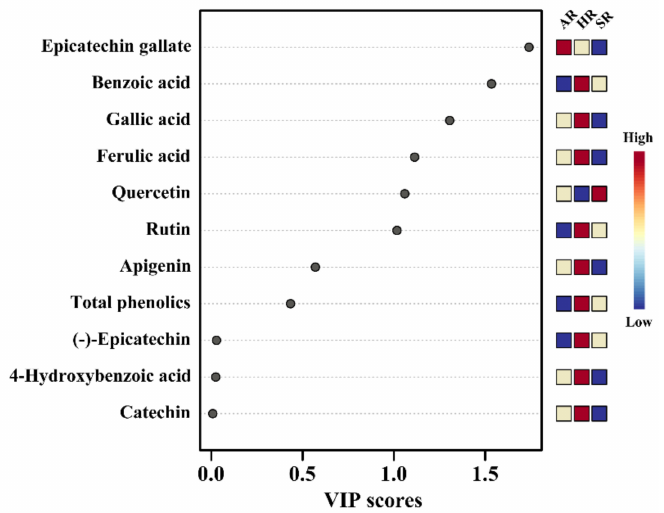
Figure 5. The main components separating the different types of root cultures of F. tataricum are based on the VIP in PLS-DA.